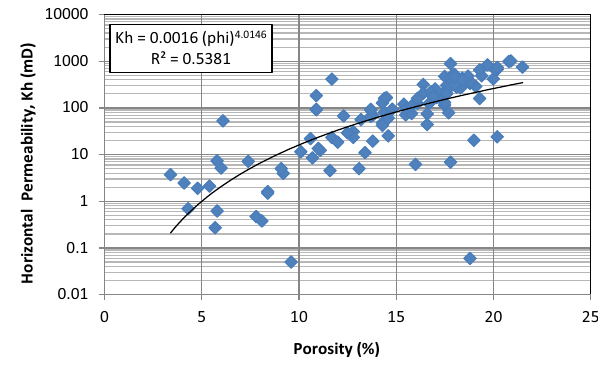
Kh = 0.0016 (phi) 4.0146 R² = 0.5381